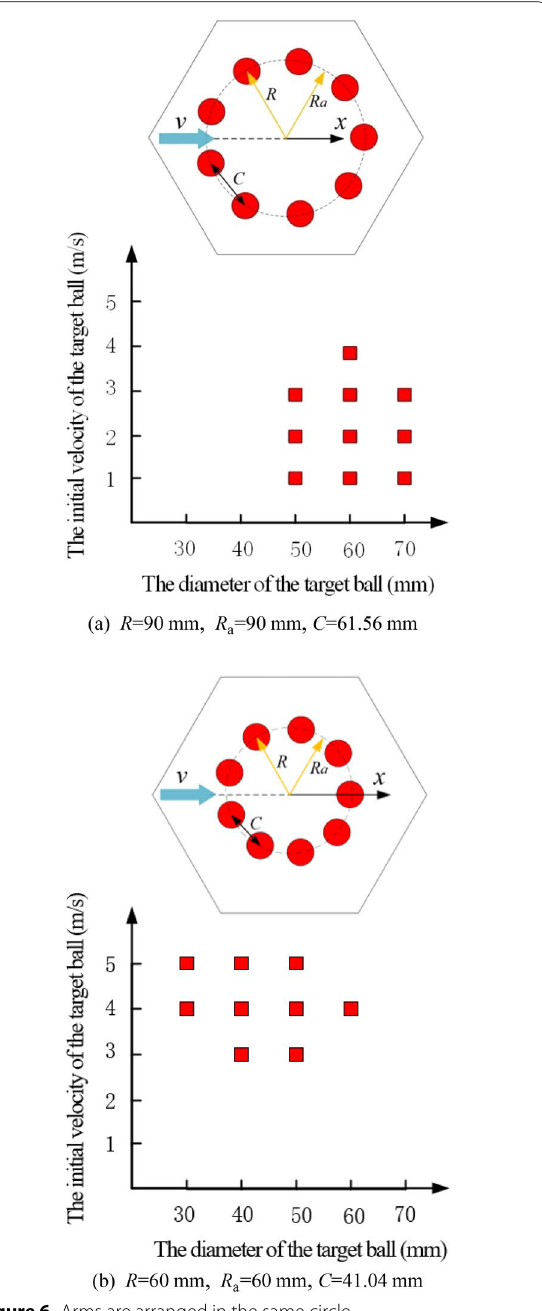
Figure 6 Arms are arranged in the same